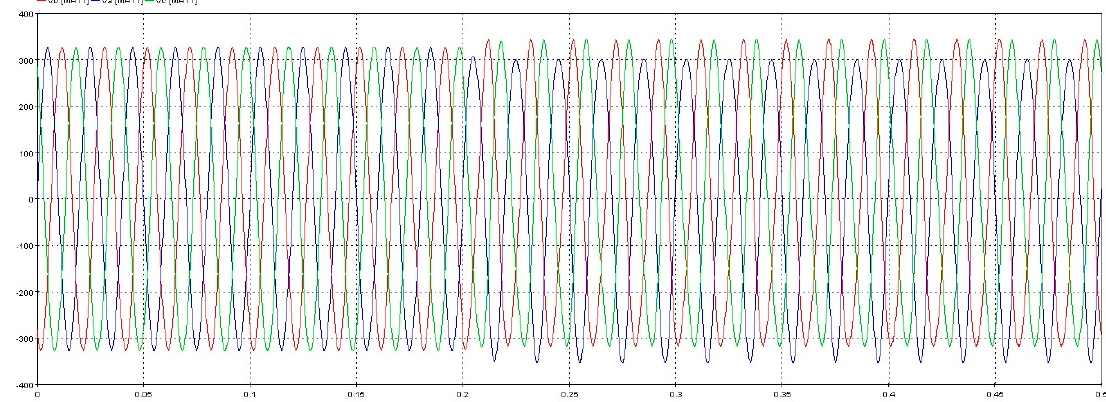
Figure 12. Output voltage waveform under droop control.